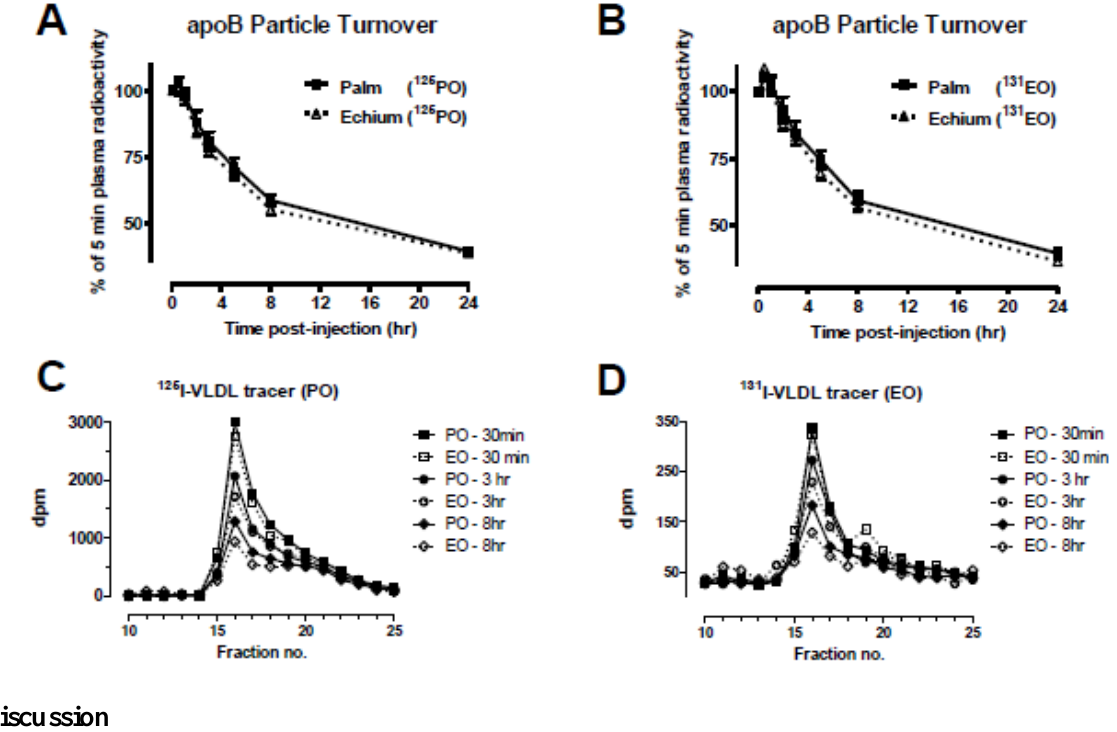
Figure 7. VLDL particle turnover. PO and EO recipient mice were injected with a mixture of 125 I-VLDL from PO-fed, and 131 I-VLDL from EO-fed donor mice via the jugular vein. ( A ) The rate of removal of VLDL tracer from PO-fed donor mice. Plasma was collected 5 min, 30 min, 1 h, 2 h, 4 h, 8 h, and 24 h after tracer injection and apoB radioactivity was measured after isopropanol precipitation. Data are presented as % of 5 min radioactivity remaining in plasma. ( B ) The rate of removal of VLDL tracer from EO-fed donor mice. See A for details. ( C ) Elution profile of PO VLDL tracer in PO and EO recipient mouse plasma. Plasma samples were separated by FPLC to determine the amount of radiolabel remaining as VLDL 30 min, 3 h, and 8 h post-injection. ( D ) Elution profile of EO VLDL tracer in PO and EO recipient mouse plasma. See C for